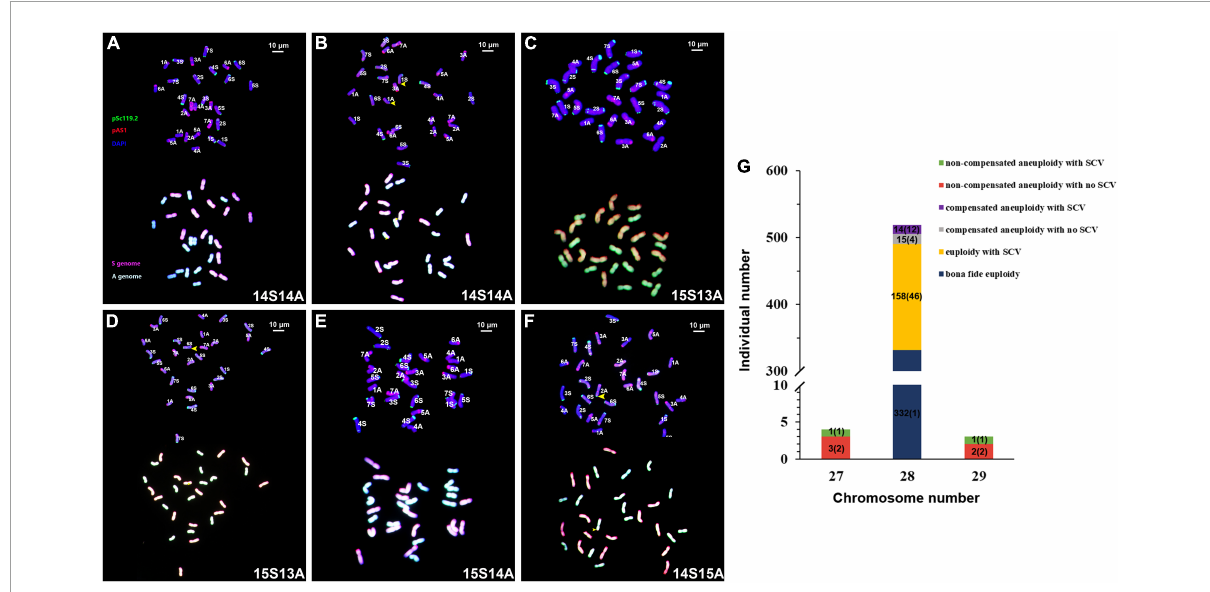
FIGURE2 Illustration of the six karyotypic categories, the distribution of relative proportions of plants belonging to each of the categories, and the numbers of distinct karyotypes contained by each category among the 526 karyotyped individuals at S9 of the specific lineage of synthetic allotetraploid wheat (S l S l AA). Images of are illustrations of the six karyotypic categories, bona fide euploid (A) , euploid with SCVs (B) , compensated aneuploid with no SCVs (C) , compensated aneuploid with SCVs (D) , non-compensated aneuploid with no SCVs (E) and non-compensated aneuploid with SCVs (F) . The pAs1 (red) and pSc119.2 (green) are used as FISH probes. Yellow arrows refer to SCVs. The genomic DNAs of Ae. longissima (S l S l , red) and T. urartu (AA, green) were used as GISH probes. The bar-chart (G) is distribution of relative proportions of plants belonging to each of the categories, while the numbers in parenthesis numbers of distinct karyotypes identified in each